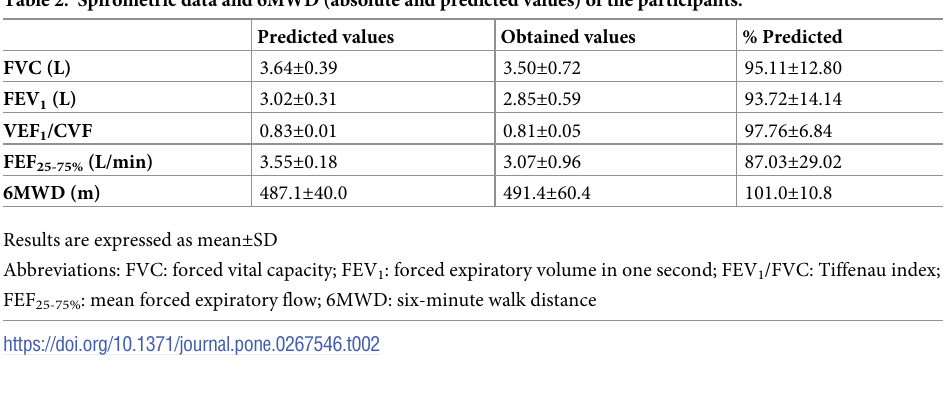
Table 2. Spirometric data and 6MWD (absolute and predicted values) of the